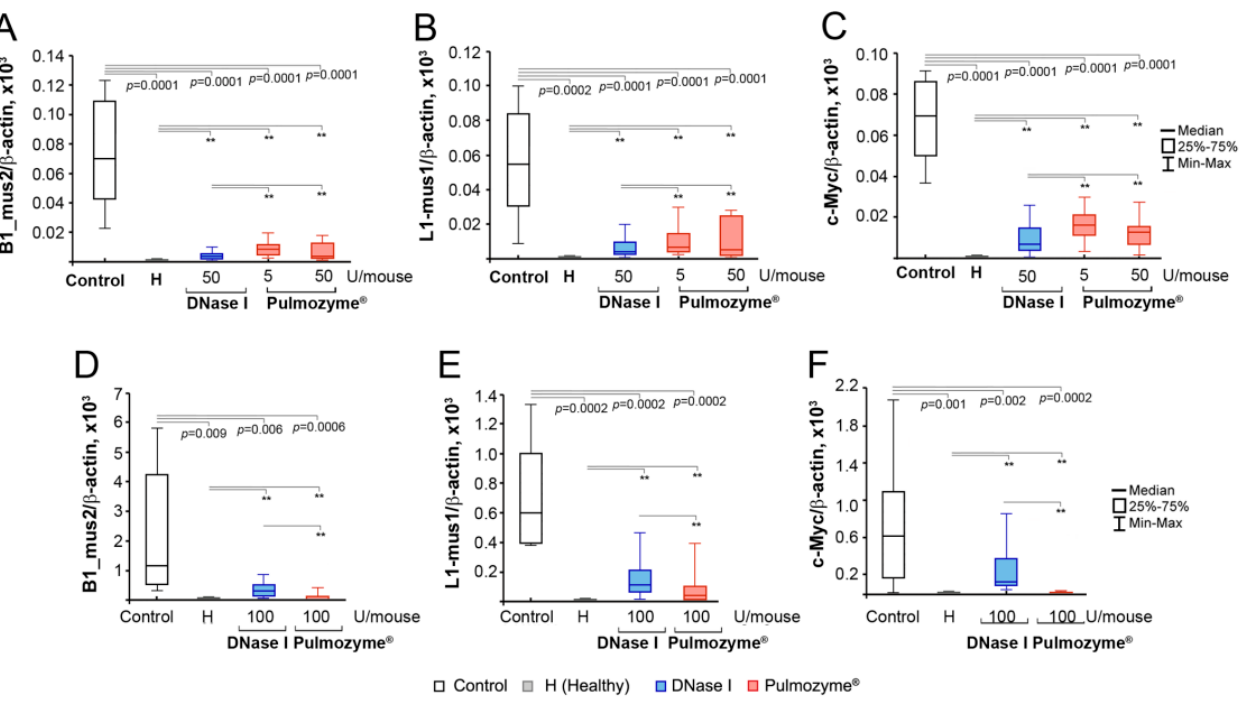
Figure 6. The levels of SINE element B1_mus2 ( A , D ), LINE element L1_mus1 ( B , E ) and c-Myc gene ( C , F ) in cfDNA of the blood serum of mice with B16 after i.m. ( A – C ) or i.n. ( D – F ) administration of Pulmozyme ® or DNase I. Data of qPCR. See Figure 2A (for i.m.) and Figure 3A (for i.n.) for experimental setup. The PCR meanings were normalized to the level of β -actin and expressed as arbitrary unit (a.u.). Data were statistically analyzed using one-way ANOVA with a post hoc Tukey test. Data are presented as median. Statistical significance p < 0.05; **—statistically insignificant difference. Control group—columns/boxes outlined in black, H (healthy)—colored grey, DNase I—blue, Pulmozyme ® —red.